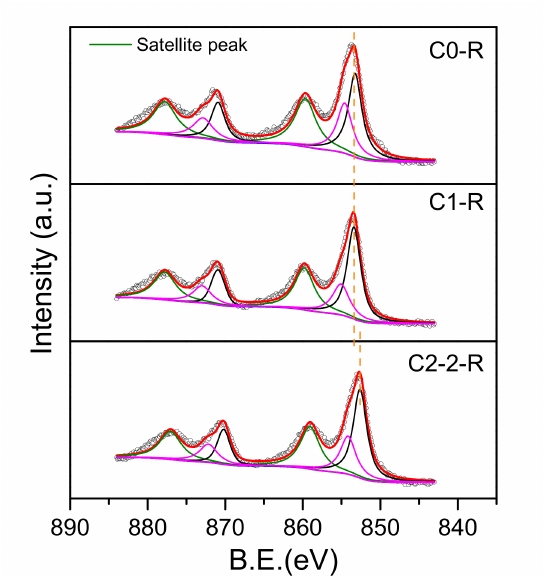
Figure 7. XPS patterns of the samples after H 2 reduction. (C0-R) 10Ni / Al 2 O 3 , (C1-R) 10Ni4Cu / Al 2 O 3 , and (C2-2-R) 10Ni4Zn / Al 2 O 3 .